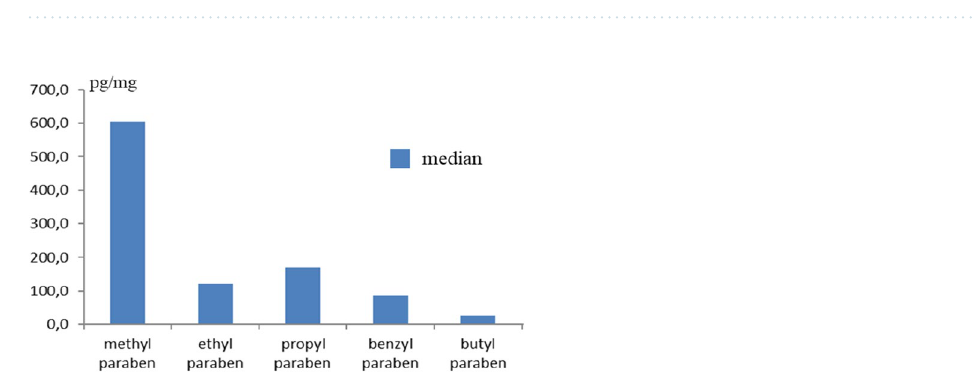
Table 1. Concentration levels of parabens (pg/mg) noted in the hair samples from 30 volunteers (one sample from each volunteer) during the present study. LOD, limit of determination; LOQ, limit of quantification; ND, not detected.